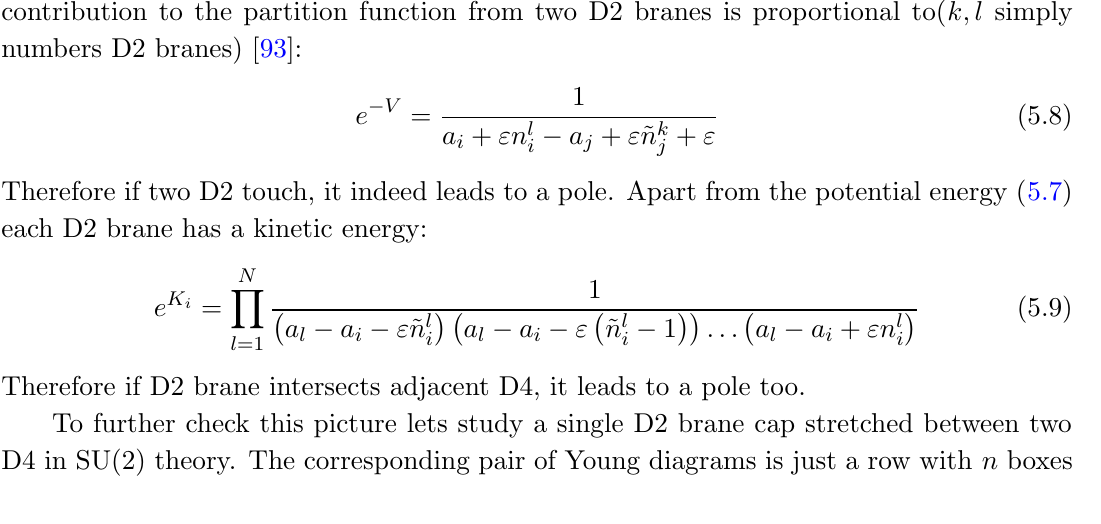
Figure 4 . Geometry of composite D0{fuzzy D2-D2 bubble. Distance N k D4 brane at x 5 = a i , there could be an arbitrary number of bubbles extending to a i + " on one side and a i (cid:0) " n k < n k +1 i